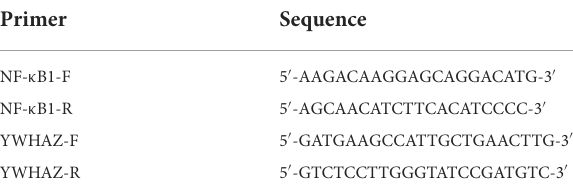
TABLE 1 The primer sequence used to analyze NF- κ B gene